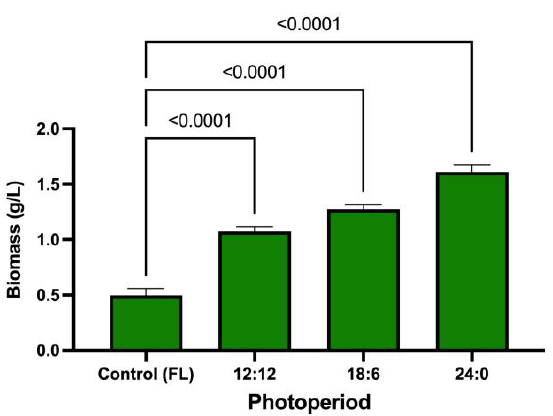
Figure 6. Biomass concentration under different photoperiods of white/red:blue LEDs.